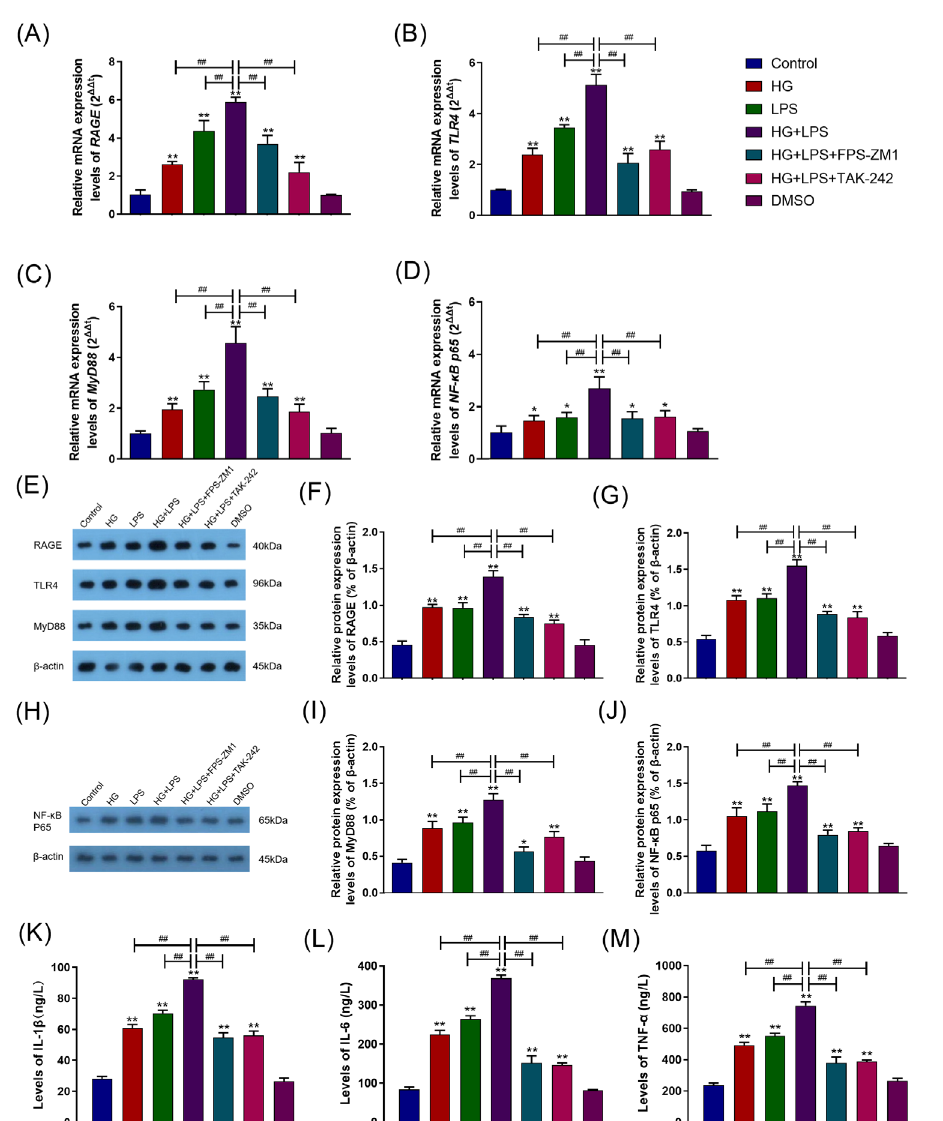
Figure 5. RAGE–TLR4 crosstalk regulated the synergism between high glucose and LPS on the inflammatory response in BAMs. ( A – D ) The levels of RAGE, TLR4, MyD88 and NF- κ B p65 mRNA expression in each group. ( E – J ) The levels of RAGE, TLR4, MyD88 and NF- κ B p65 protein expression in each group. ( K – M ) The levels of IL-1 β , IL-6, and TNF- α in each group. Each experiment was carried out at least three times, and the data were displayed using mean ± SD. *, p < 0.05; **, p < 0.01 vs. control group; ## , p < 0.01 vs. other treatment groups; One-way ANOVA.